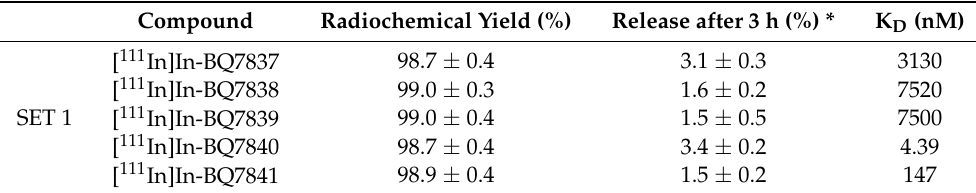
Table 1. Radiochemical yield, the release of free indium-111 after EDTA-challenge for 3 h, and the K D -value for compound [ 111 In]In-BQ7837-41 (SET 1). Measurements were done in triplicate. * the labelled compound was challenged with 1000-fold excess of